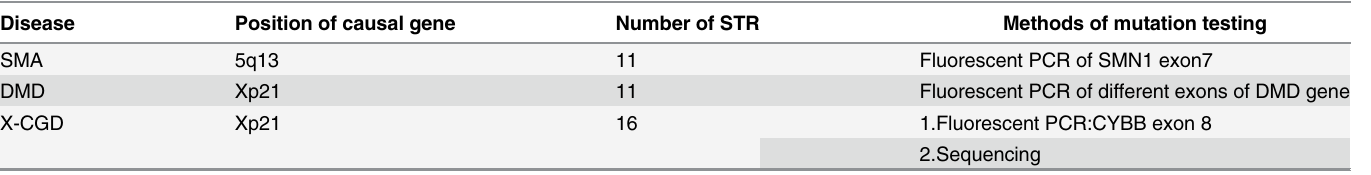
Table 2. The number of STR for each disease and mutation testing